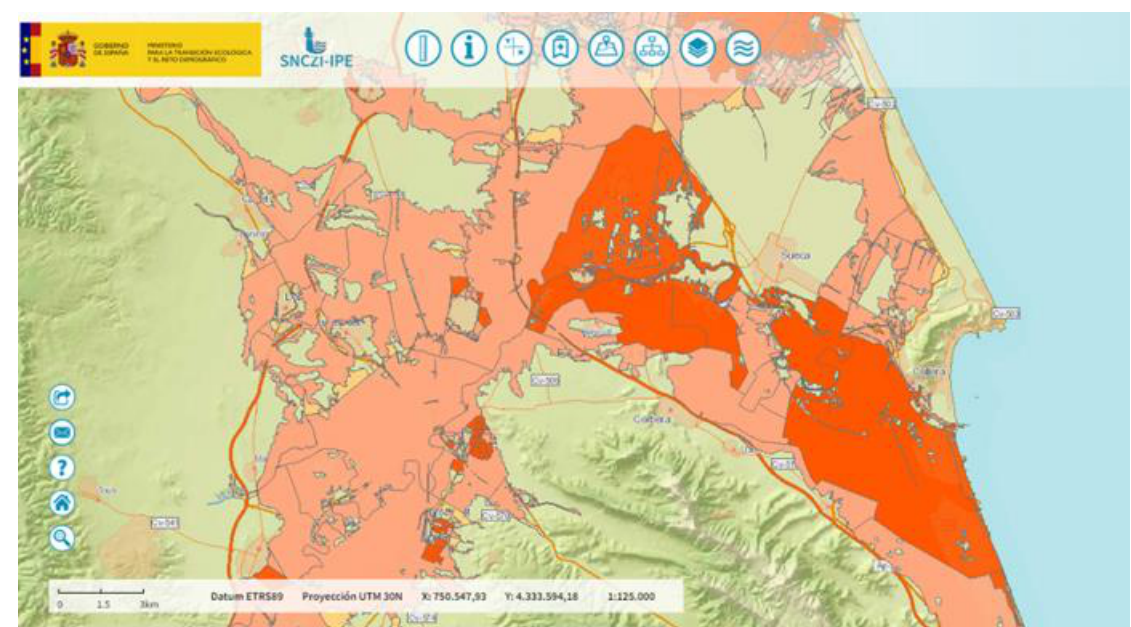
Figure 6. Image capture of the risk layers of the NFZMS viewer (mouth of the Júcar river). Source: Ministry for the Ecological Transition and Demographic Challenge [48]. Own elaboration.